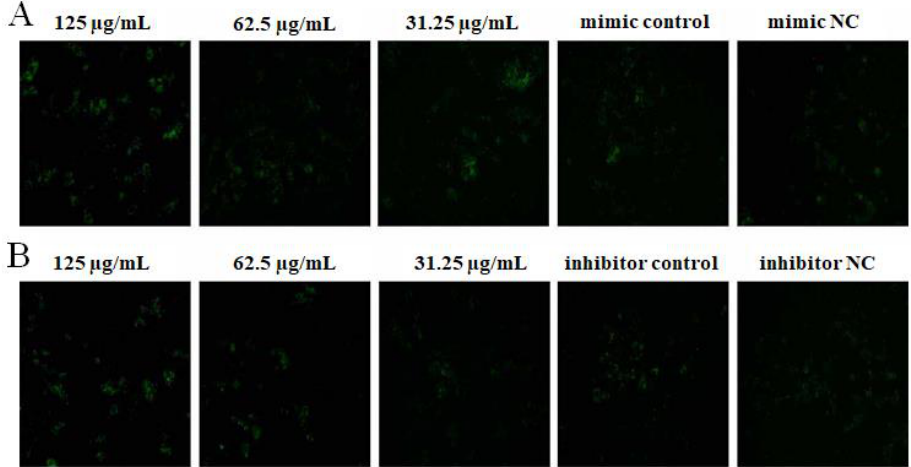
Figure 4. The effect of OPL on the phagocytosis of FITC-Dextran. ( A ): The group transfected with miR-4796 mimic phagocytosis of FITC-Dextran ( × 200); ( B ): the group transfected with miR-4796 inhibitor phagocytosis of FITC-Dextran ( × 200).